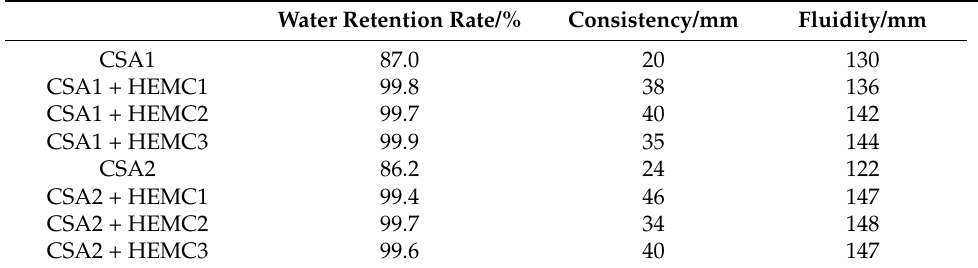
Table 4. Water-retention rate, consistency and fluidity of fresh CSA cement mortars with and without